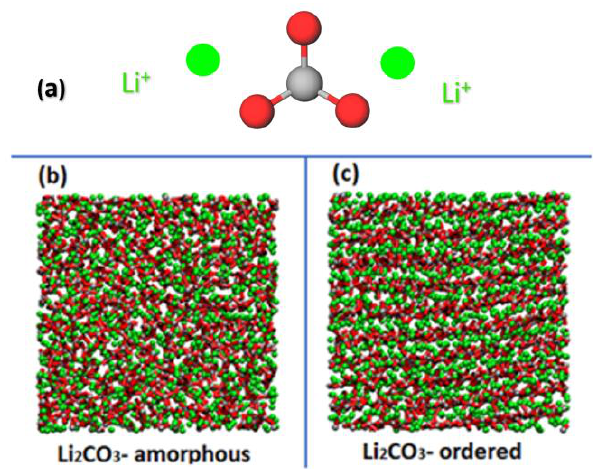
Figure 1. Snapshots of ( a ) the chemical structure of lithium carbonate, ( b ) the amorphous phase of Li 2 CO 3 at 550 K, and ( c ) the ordered phase of Li 2 CO 3 that formed in two realizations at 550 K (see text for discussion).